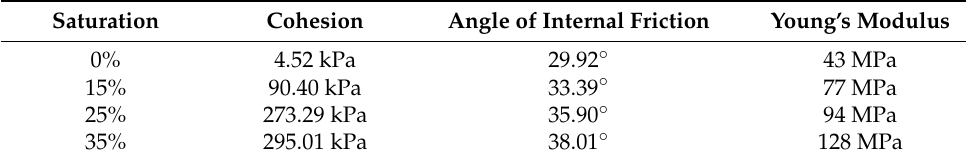
Table 4. Mechanical parameters of hydrate samples with different saturations.